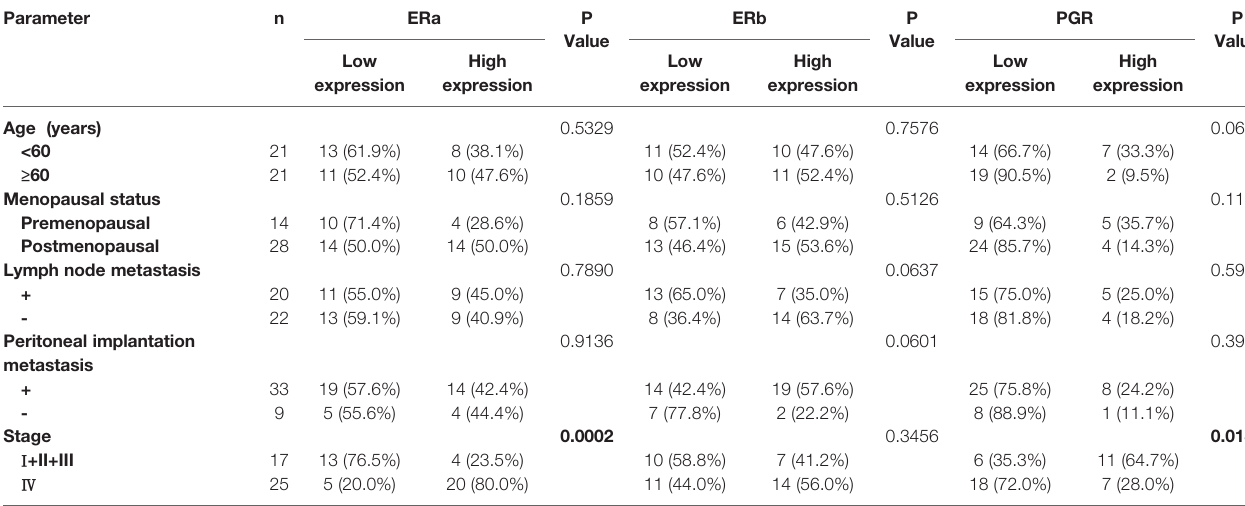
ERb P PGR P Value Value Value Low High Low High Low High expression expression expression expression expression expression